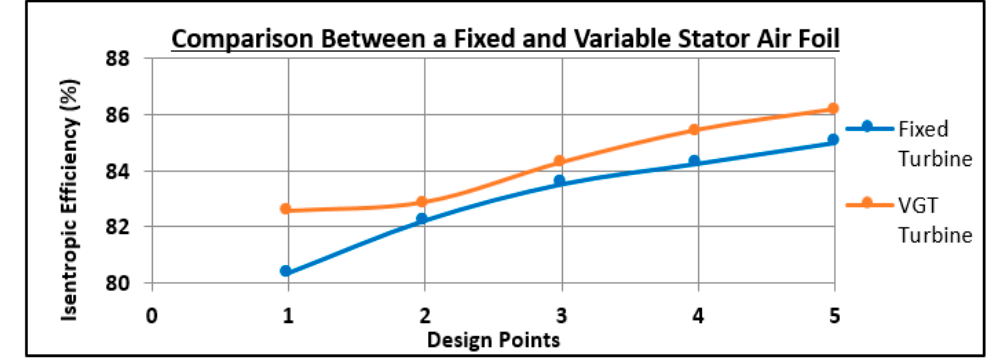
Figure 40. Graphical representation of the improvement of efficiency through variable geometry.